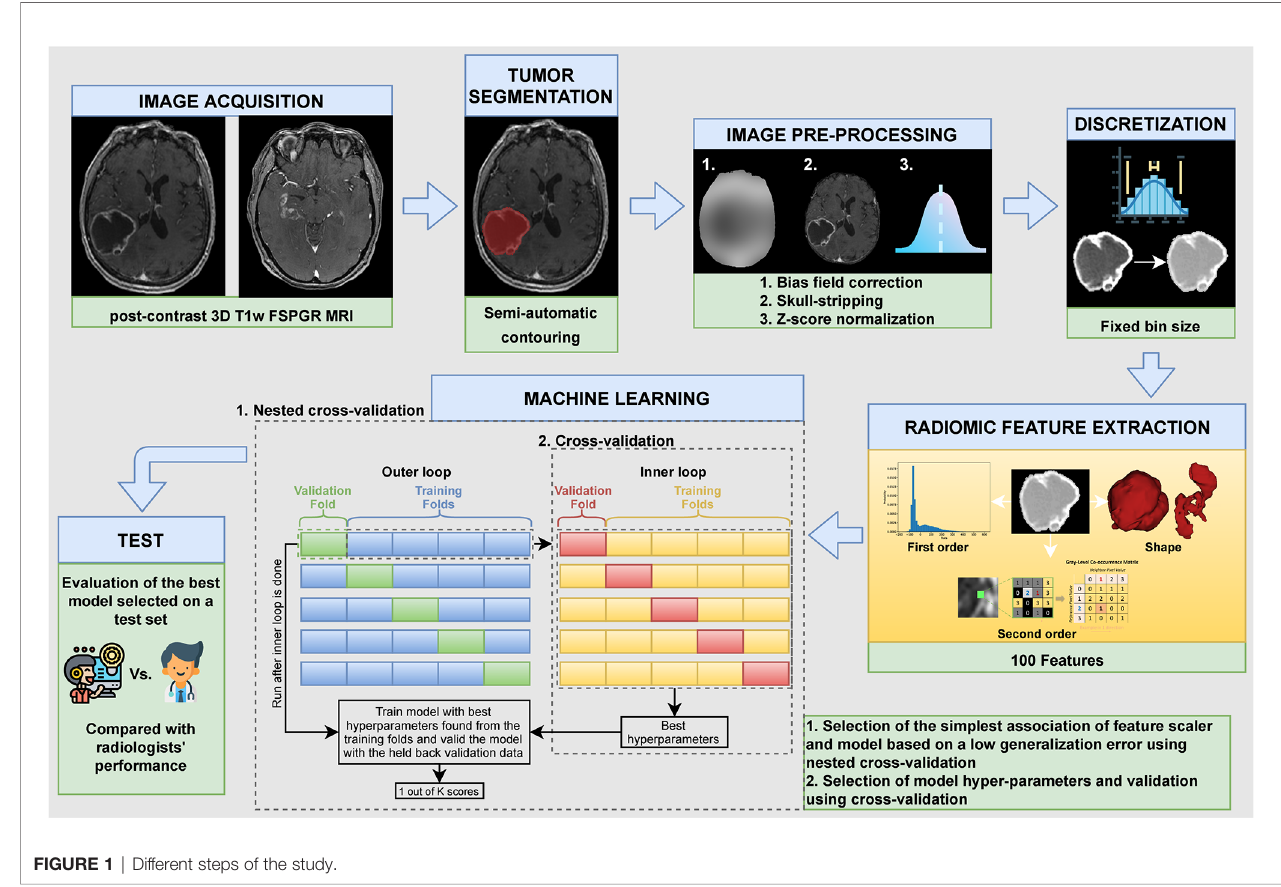
FIGURE 1 | Different steps of the